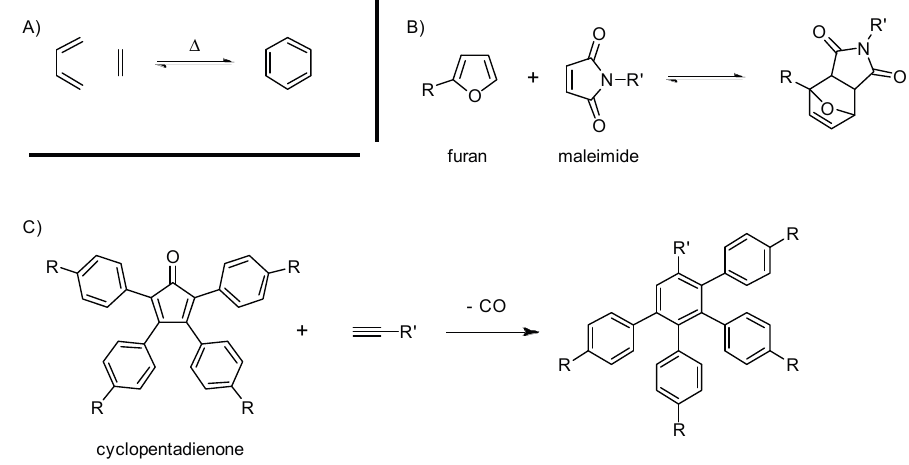
Scheme 3. General scheme for the Diels-Alder (DA) reaction ( A ), an example of rDA with furan and maleimide ( B ) and the cyclopentadienone popularized by the Mülllen group ( C